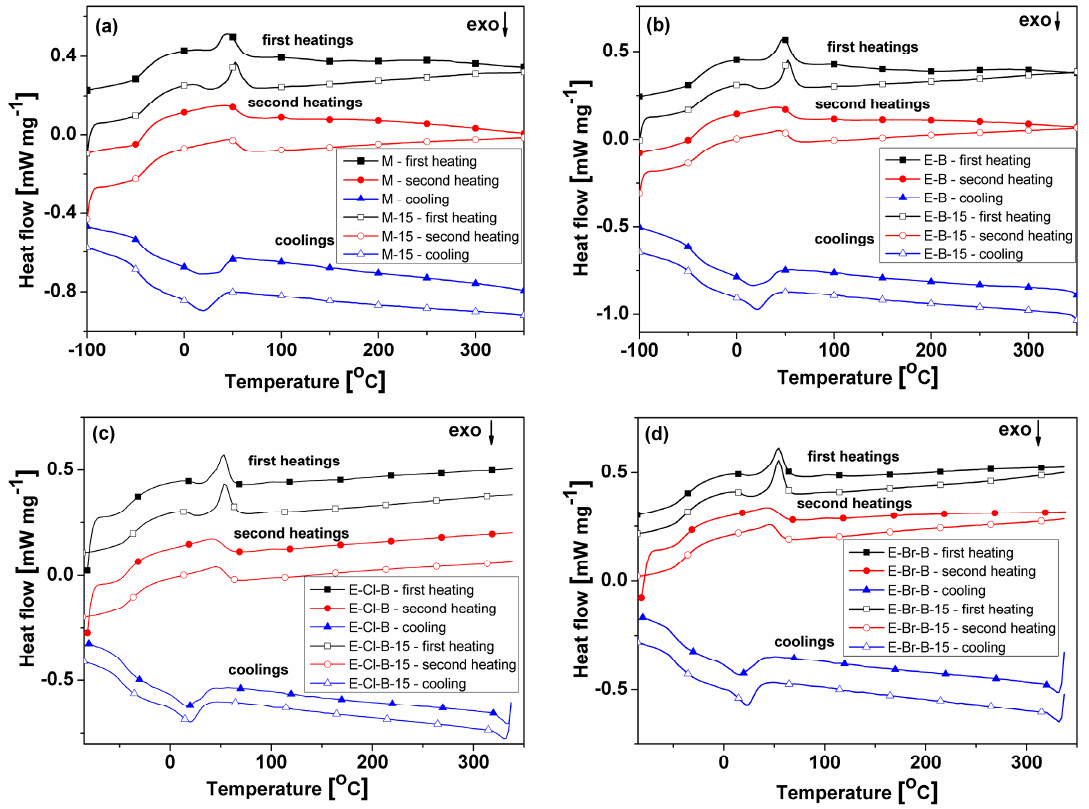
Figure 14. DSC thermograms of nonirradiated samples and those irradiated at 150 kGy: ( a ) M; ( b ) E–B; ( c ) E–Cl–B; ( d ) E–Br–B. Table 5. DSC data of EPDM/butyl rubber composites.